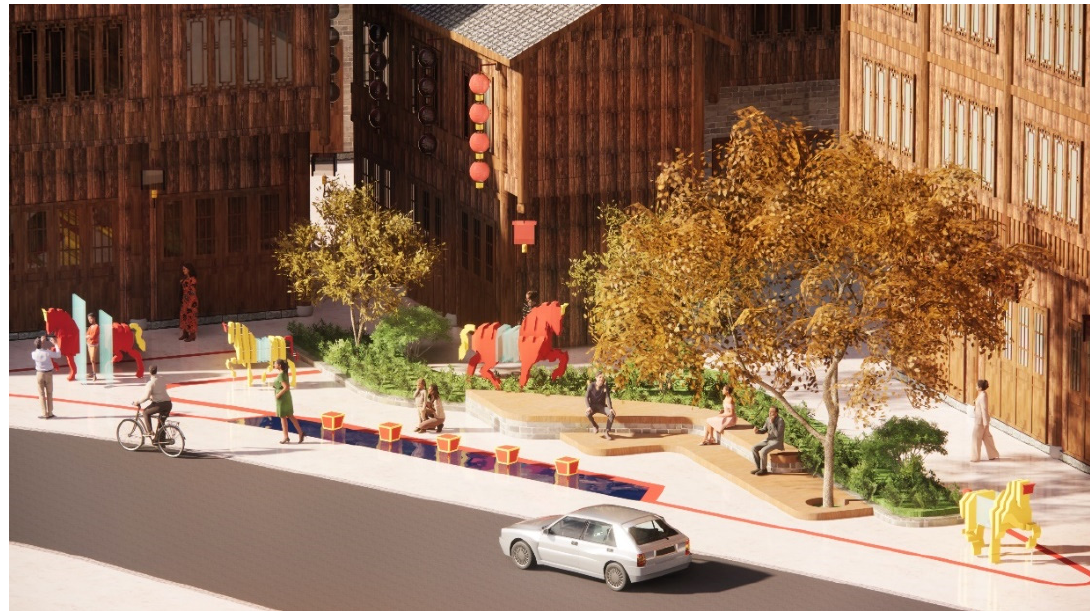
Figure 21. Dragon and phoenix lion lamp culture landscape space.